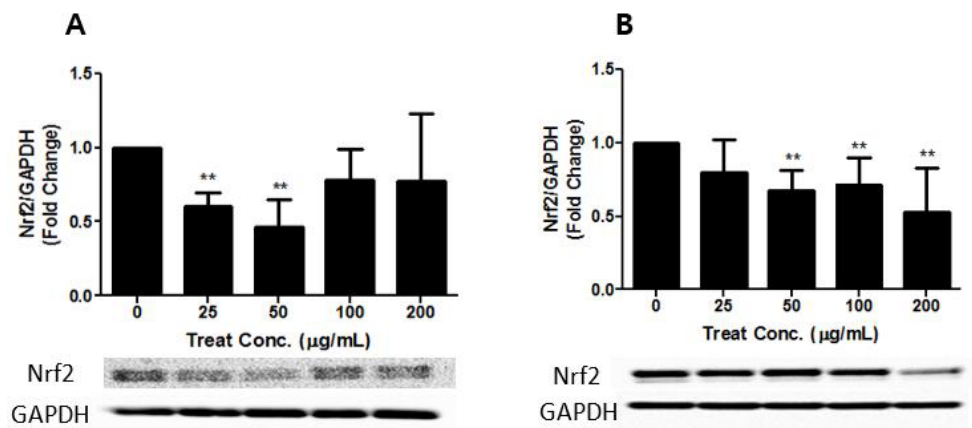
Figure 7. Activation of Nrf2 in cytosol of A549 cells after treatment with PM2.5 ( A ) and TSP ( B ). Cells were exposed to PM2.5 and TSP at 0, 25, 50, 100, and 200 µg/mL for 24 h. The values are reported as the mean ± SD (Student’s t -test, ** p < 0.01, vs. control).